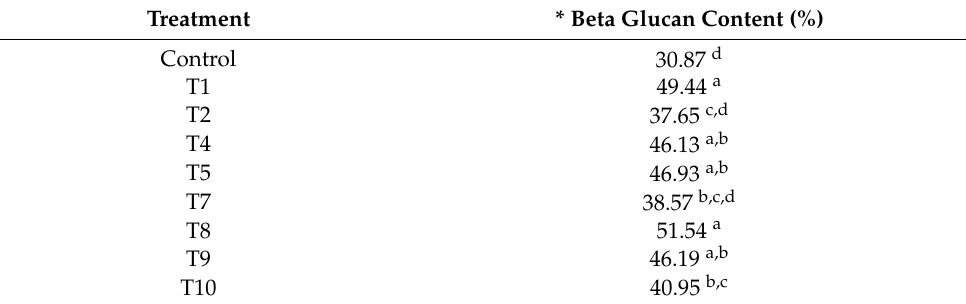
Table 8. Beta glucan content of Pleurotus ostreatus